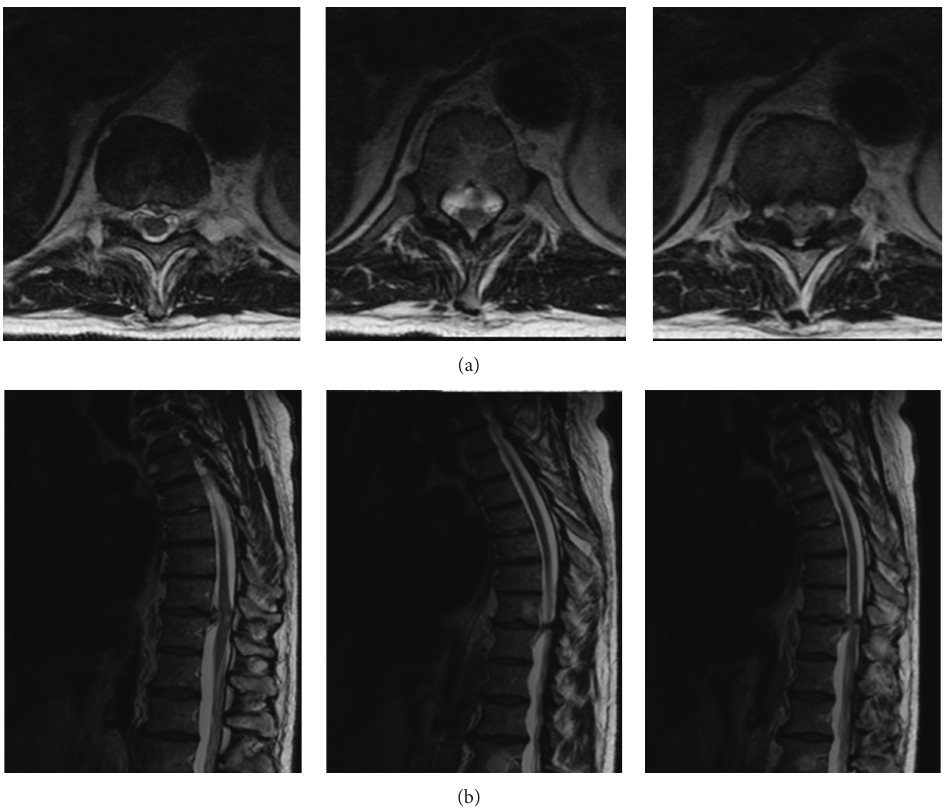
Table 1: Atypical symptoms attributable to thoracic disc herniation. Atypical symptoms from thoracic disc herniation Constipation Hypotonic bladder Saddle anesthesia and/or lack of anal reflex Aconuresis Bowel dysfunction Emesis Gastroparesis